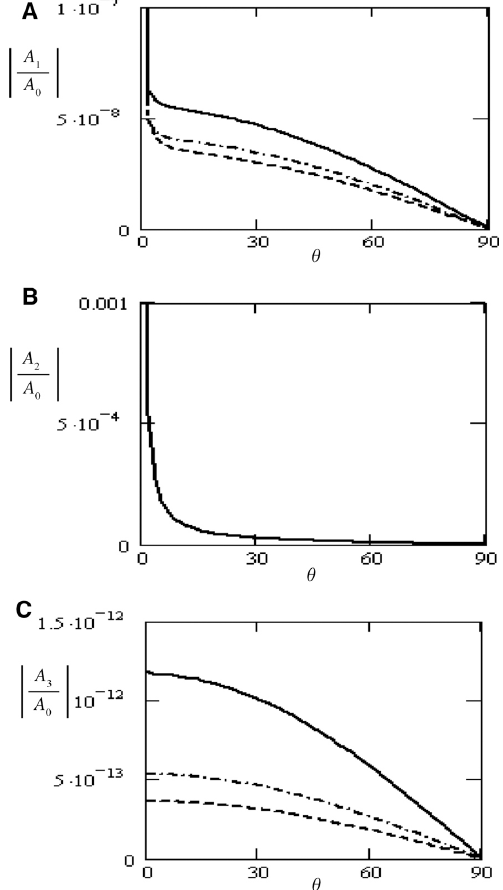
Figure 2: Variations of a magnetic field H = 0.1___, 0.3 – . – ., 0.5 – – – on the magnitude of amplitude ratios with respect to the angle of